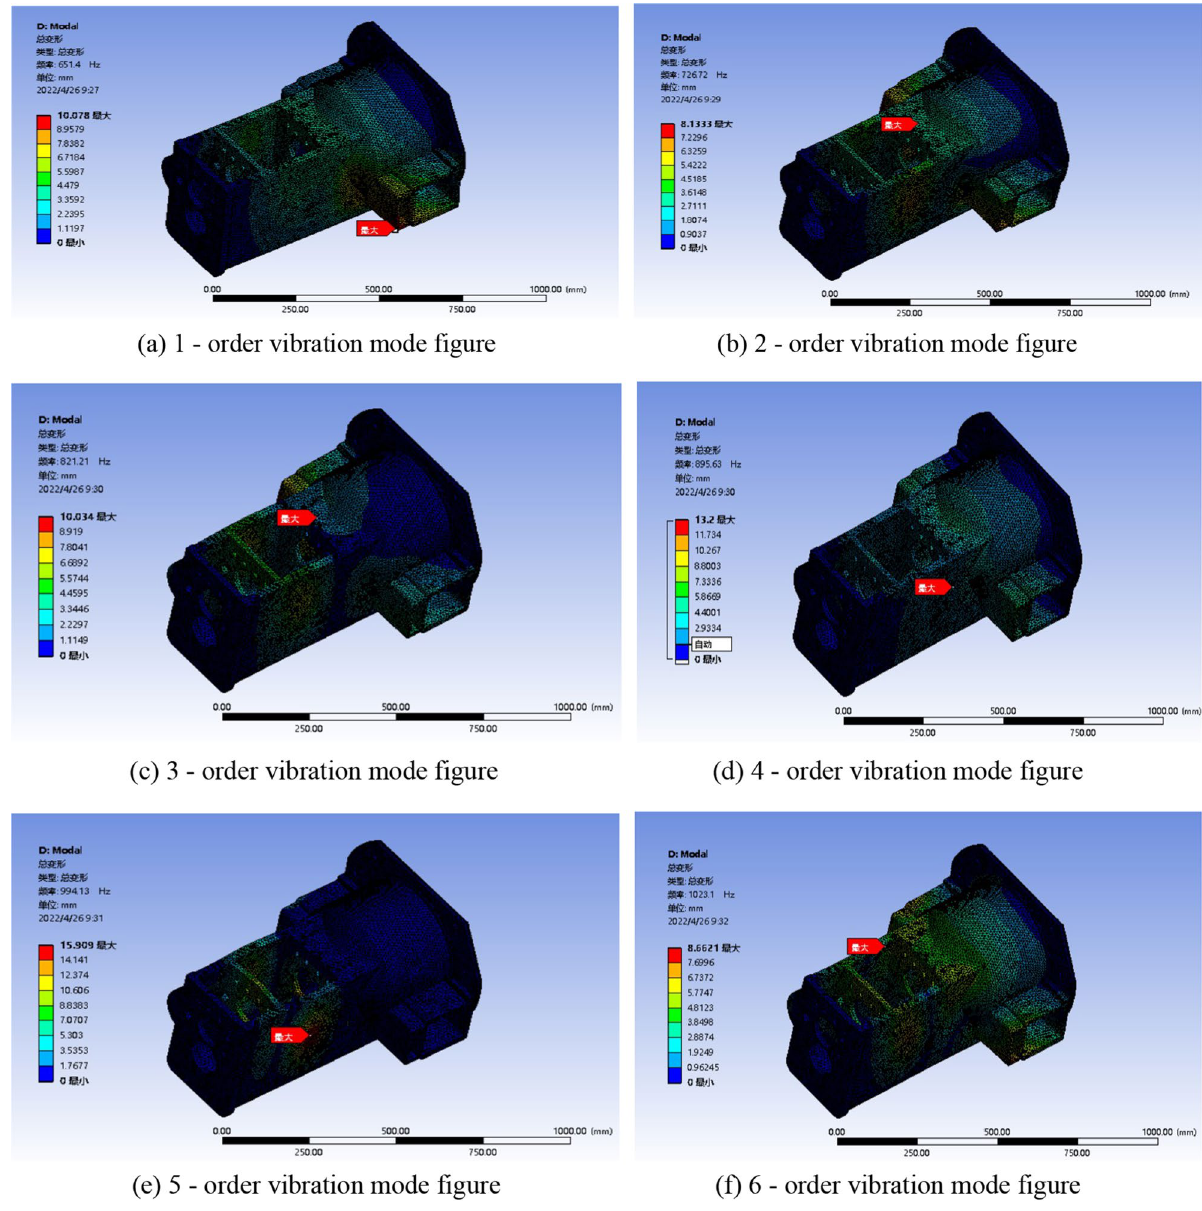
Figure 10. 6-order modal analysis of gearbox housing.